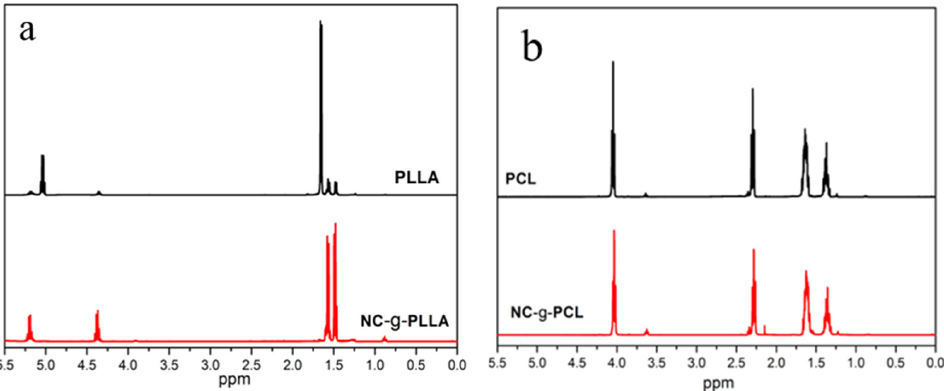
Figure 4. 1 H-NMR spectra for: PLLA and NC-g-PLLA ( a ) and PCL and NC-g-PCL ( b ) synthesized under the same experimental conditions.